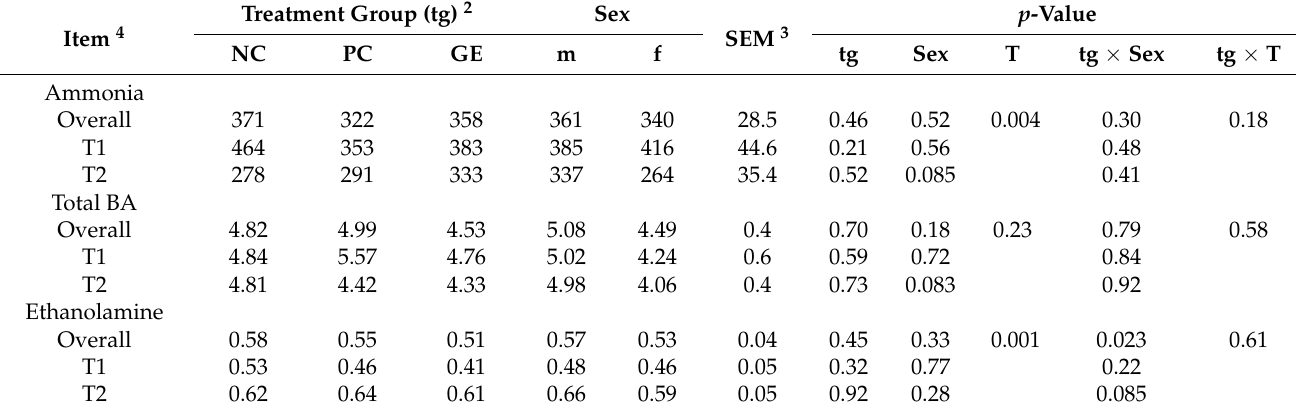
Table 8. Effect of using NC and PC for testing dietary GE supplementation on the concentrations of ammonia ( µ g/g) and biogenic amines (BA) (mmol/kg) in colonic content of weaning piglets at two different sampling points 1 . Item 4